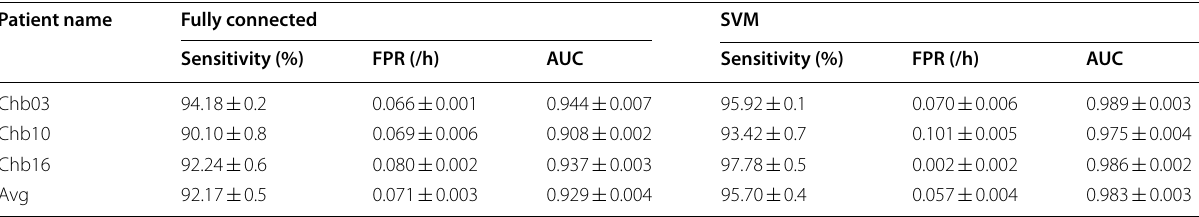
20 min, SPH 10 min) = =